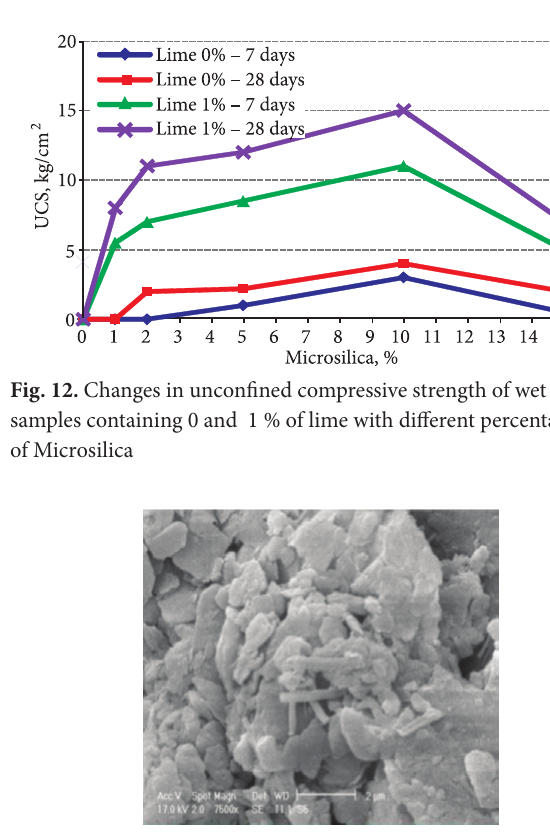
Fig. 13. Electron microscope image of the 7 day curing samples with 5% Lime and 0 % Microsilica